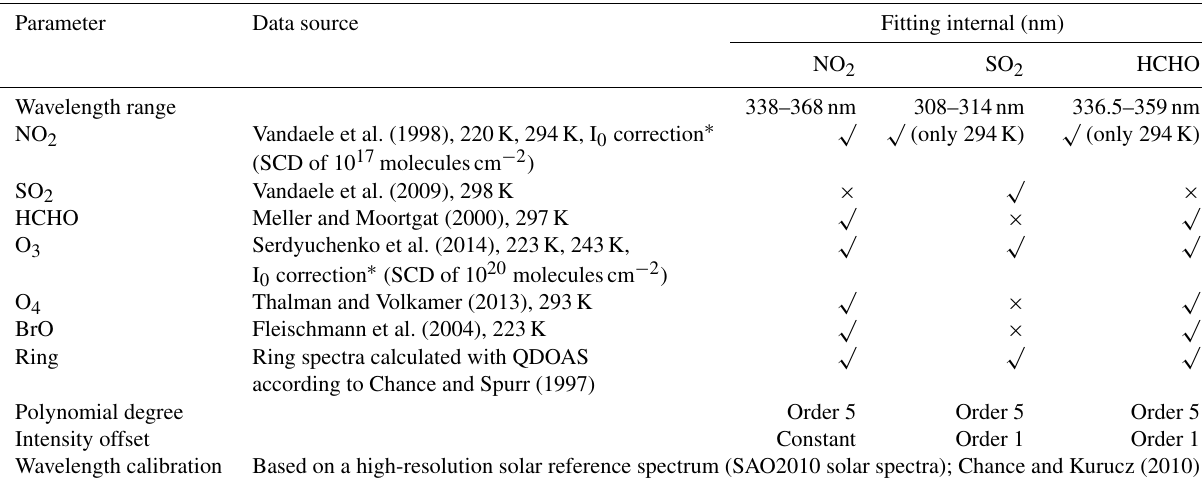
Table 2. Summary of the DOAS retrieval settings used for the NO 2 , SO 2 , and HCHO slant column densities’ retrieval.